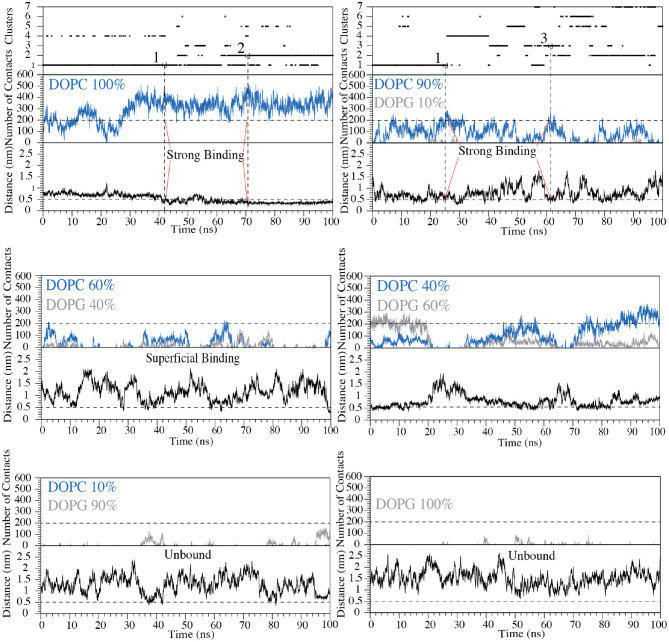
Cluster analysis, number of contacts and distance between Cα atom of Val5 and the polar heads of phospholipids are reported as a function of the simulation time for each of the six systems with the following zwitterionic/negatively charged phospholipids composition: pure DOPC, DOPC/DOPG 90:10, 60:40, 40:60, 10:90, and pure DOPG. The states representing “strong binding” modes in DOPC and DOPC/DOPG 90:10 are labeled by red arrows. The horizontal dashed line shows the cut-off value for the number of contacts between C8 and phospholipids used to distinguish the bound state from the unbound state of C8. The vertical dashed lines define the structures of the cluster families that were selected and animalized in comparison to the NMR structures.